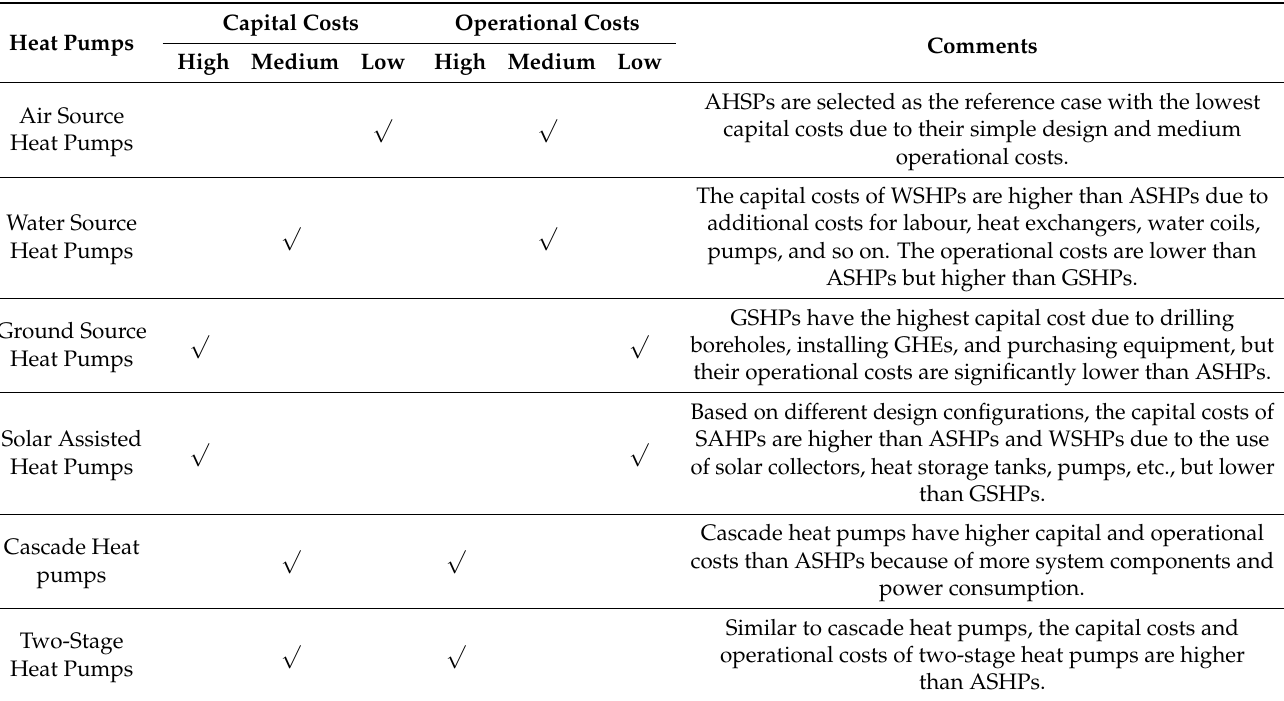
Table 8. Cost comparison among various heat